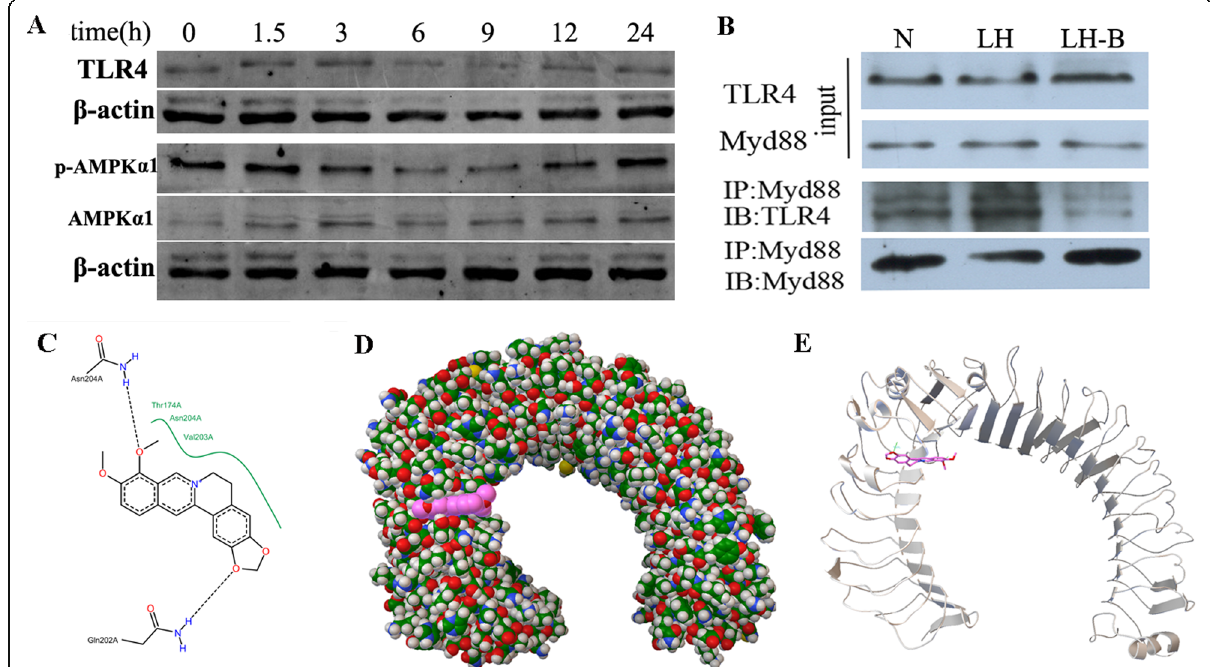
Fig. 9 Effects of BBR on TLR4 and p-AMPK protein levels ( a ) and the interaction between TLR4 and MyD88 ( b ) induced by LPS in Raw264.7 cells. N, normal control group; LH, high LPS group; LH-B, high LPS + BBR group. c - e Molecular docking diagrams of the interaction between BBR and TLR4. c 2D docking diagram of the interaction between BBR and TLR4. The black dotted line and green curve indicate a hydrogen bond and hydrophobicity, respectively. BBR can form hydrogen bonds with Thr174, Asn204 and Val203, and can also form hydrophobic interactions with the Asn204 and Gln202 residues in the A chain of TLR4. d The surface structure of the ligand formed around the active centre of the A chain of TLR4. Red, BBR. e The conformation of the interaction between the ligand and the A chain of TLR4 after